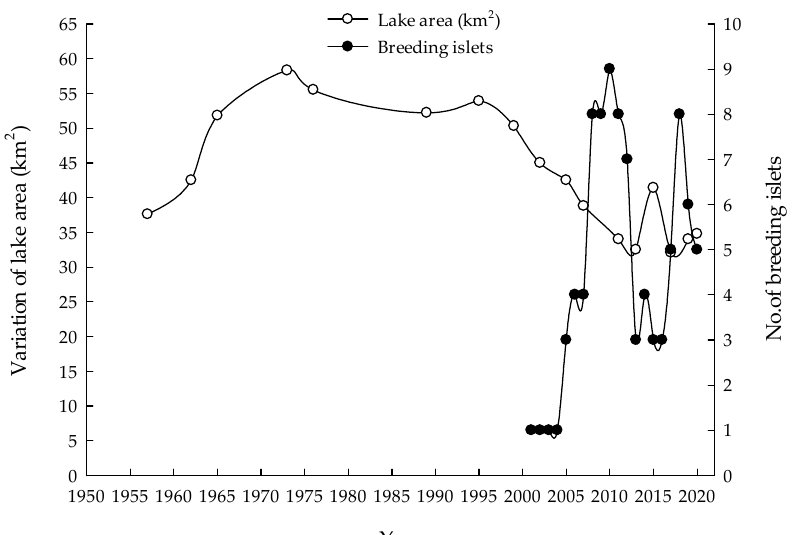
Figure 2. Relationship between lake area and breeding islets in Hongjian Nur over 60 years.